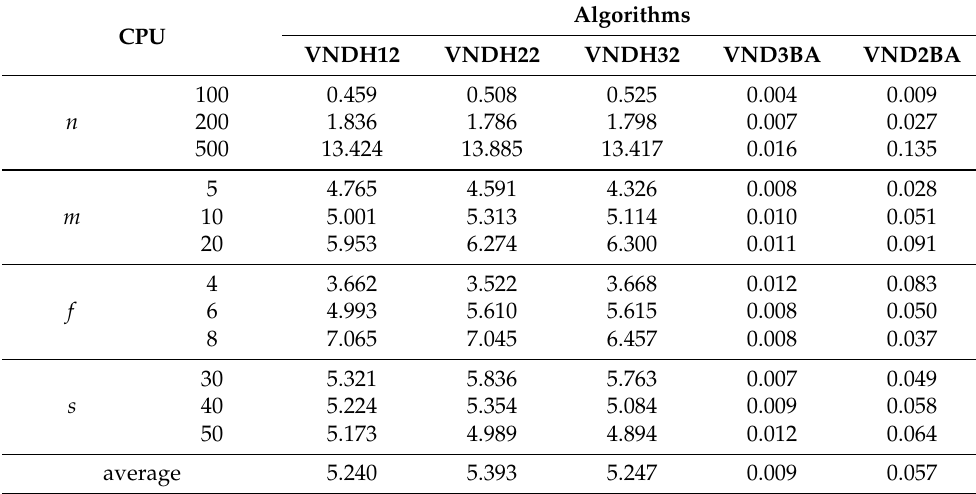
Table 14. CPU time of VND